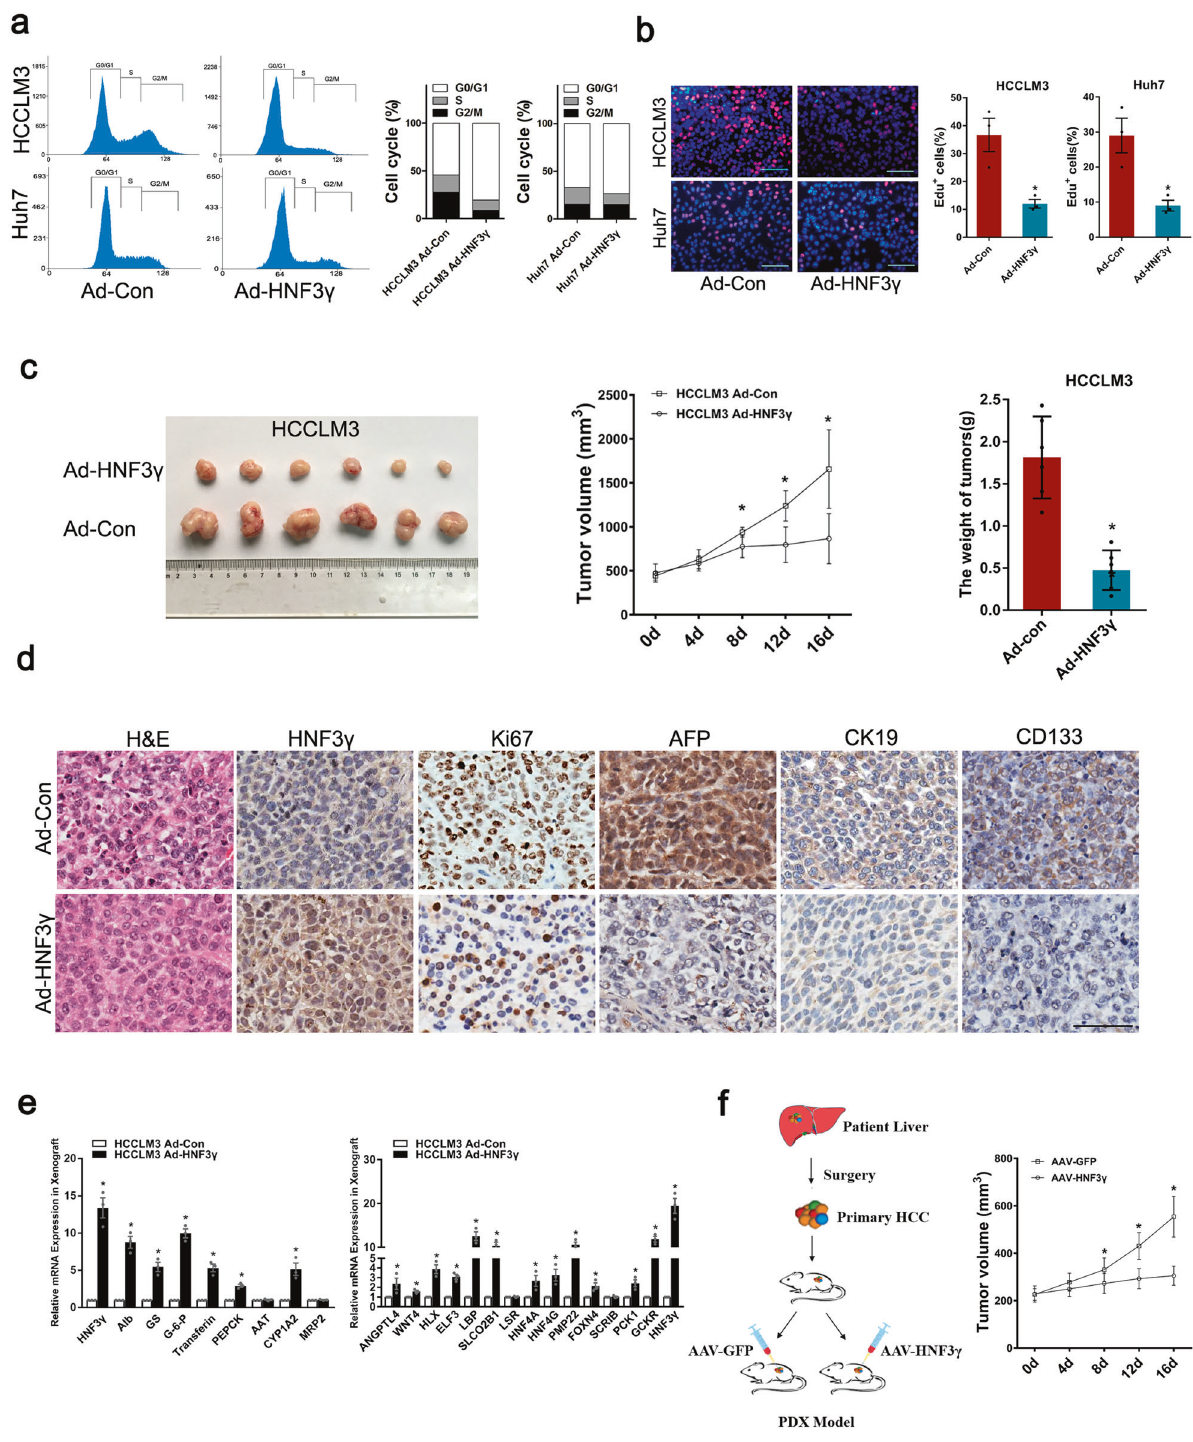
Fig. 6 HNF3 γ inhibits HCC cell proliferation and xenografted HCC growth. a Flow cytometry analysis of HCCLM3 or Huh7 cells infected with Ad-HNF3 γ or Ad-Con. b Representative images of proliferating HCCLM3 or Huh7 cells indicated by EdU staining are shown. The nuclei were counterstained with DAPI. EdU + cells were stained with red immuno fl uorescence. Scale bars, 25 μ m. Results were expressed as means ± SEM. c HCCLM3-xenografted tumor morphology, tumor growth curve, and average tumor weight in Ad-HNF3 γ and Ad-Con groups are shown. d Representative images of IHC staining of HNF3 γ , Ki67, AFP, CK19, and CD133 in the xenografted tumors are shown. Scale bar, 100 μ m. e The expression of hepatocyte-speci fi c genes and differentiation-associated genes in HCCLM3-xenografted tumors were examined by real-time PCR. f Patient-derived HCC xenografts were treated with either AAV-HNF3 γ or AAV-GFP. The size of xenografted tumors was measured every week, and the volume was calculated